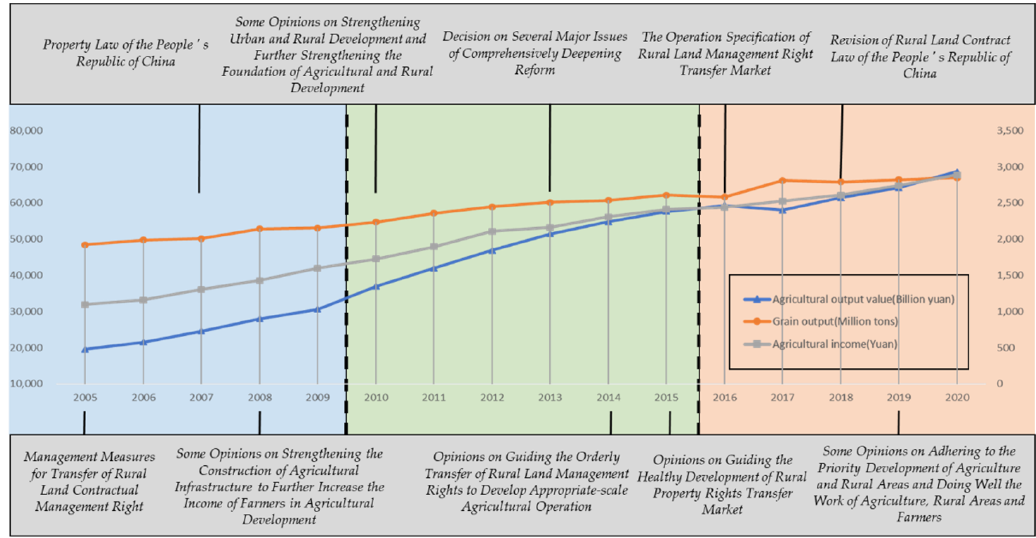
Figure 1. Change of the rural land reform system.